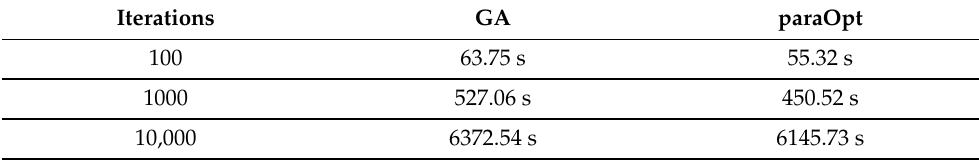
Table 12. CPU time for pattern1 of CFD model .